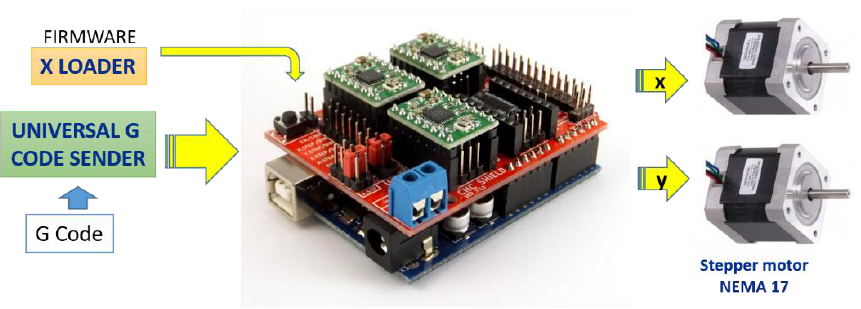
Figure 7. Arduino — CNC shield control — Stepper motor with A4988 driver. Figure 7. Arduino—CNC shield control—Stepper motor with A4988 driver. The drivers for controlling the stepper motors are inserted in the CNC shield card.